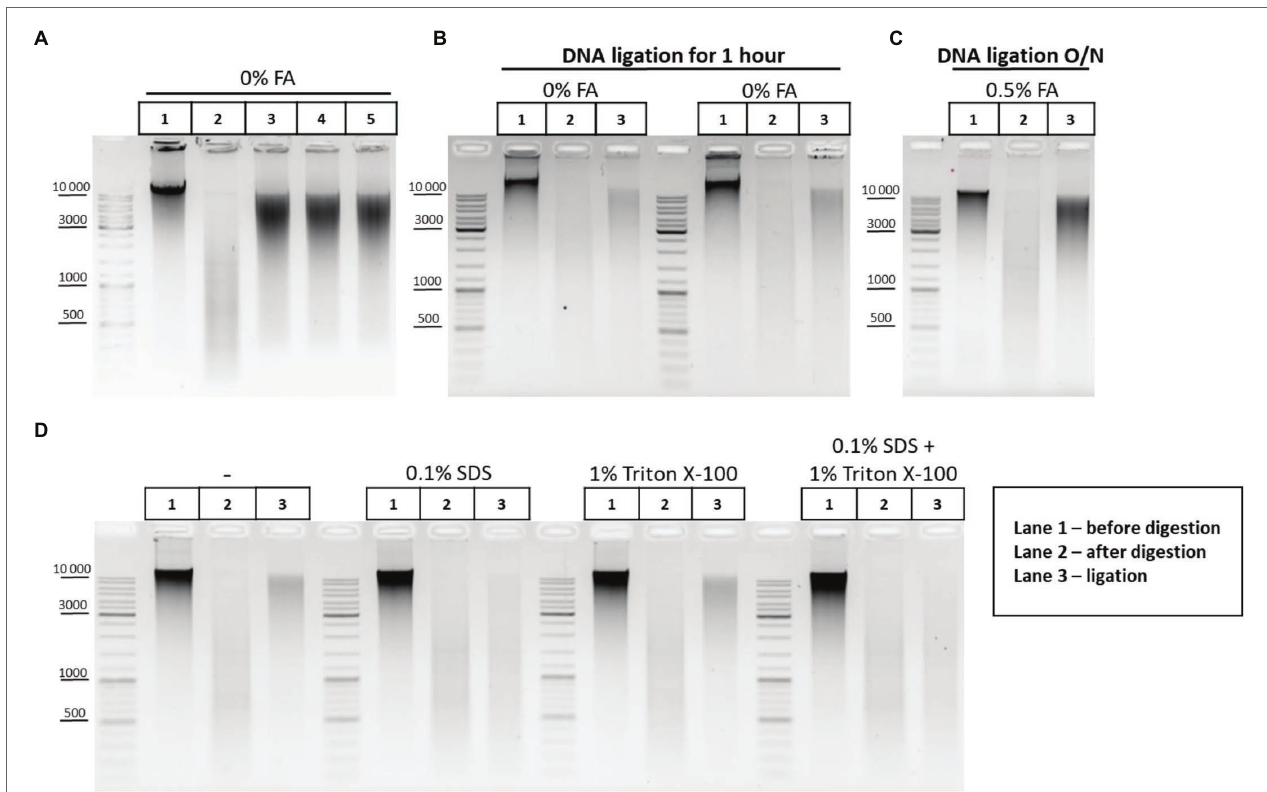
FIGURE 6 | DNA ligation in nuclei and in solution. (A) Patterns of the genomic DNA digested with DpnII and ligated in solution with different concentrations of T4 DNA ligase. Genomic DNA was isolated (lane 1) and cut with DpnII as in Figure 5E . Then, RE was heat inactivated and DNA was purified on AMPure XP beads and subjected to electrophoresis (lane 2) or ligated for 1 h as in Figure 5E in a reaction volume of 20 μ l using 1 μ l of commercially available preparation of T4 DNA ligases in the following concentrations: lane 3–5 Weiss U/ μ l (Thermo, #EL0014), lane 4–1 Weiss U/ μ l (Sibenzyme, #E320), and lane 5 – high concentrated ligase of 10 Weiss U/ μ l (Sibenzyme, #E330). After ligation, the DNA was again purified using AMPure XP beads and subjected to electrophoresis. One of the three replicate experiments is shown. (B) Pattern of ligation of uncross-linked chromatin in 1 h. С ells were left unfixed (0% FA), were washed with 1X PBS at RT, and were lysed, incubated in lysis buffer, and washed as in Supplementary Figure S1A . Then, nuclei were treated with SDS and Triton X-100 as in Figure 5F . Nuclei were then washed with 1X RB and after that RE digestion of the chromatin and DNA ligation in the nuclei were implemented as in Figures 5A – D . Control aliquots were